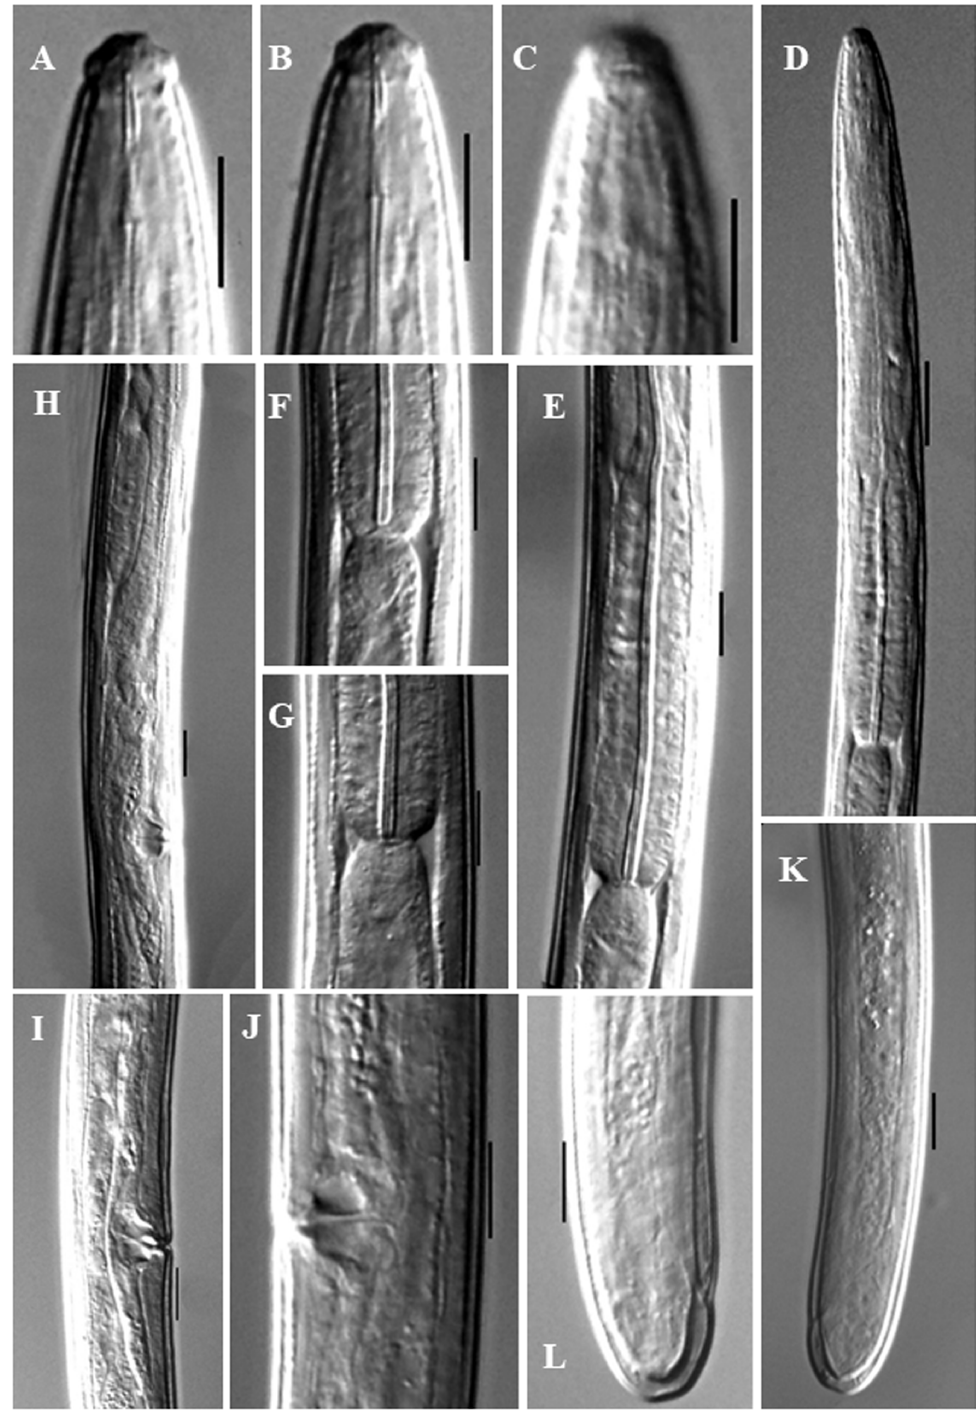
Fig. 16. Tylencholaimus tamiliensis sp. nov., ♀ (LM photographs). A, F . Paratype 1, (slide 2). B, G, J . Paratype 2 (slide 2). C . Paratype 5 (slide 3). D, I . Paratype 4 (slide 3). E . Paratype 8 (slide 4). H . Paratype 6 (slide 3). K–L . Holotype (AMU/ZD/NC/ Tylencholaimus tamiliensis /1). A–B . Anterior region. C . Anterior region showing amphid. D . Pharyngeal region. E . Expanded part of pharynx. F–G . Pharyngo-intestinal junction. H–I . Genital system. J . Vulval region. K . Posterior region. L . Posterior end. Scale bars: A–C, E–G, I–L = 10 μm; D, H = 20